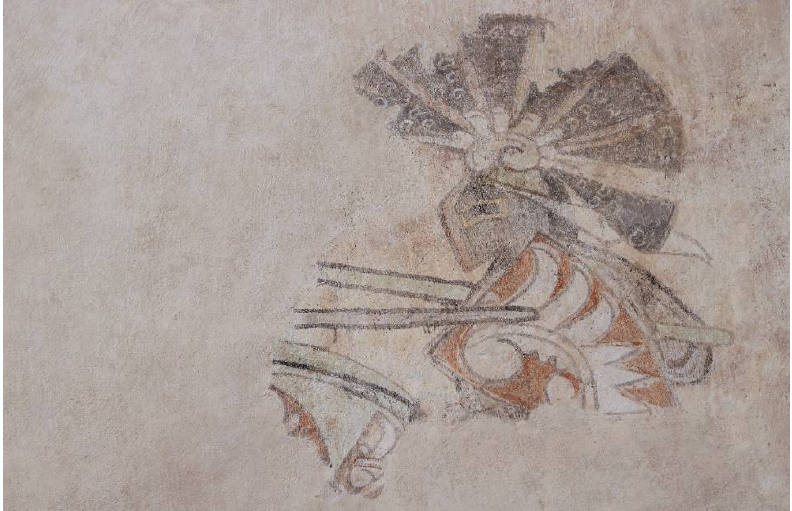
Figure 19. Velké Meziříčí, detail of a knight with the coat of arms of the lords of Lomnice on the east wall, first quarter of the 14th century. Photo by František Záruba, the author’s own work.